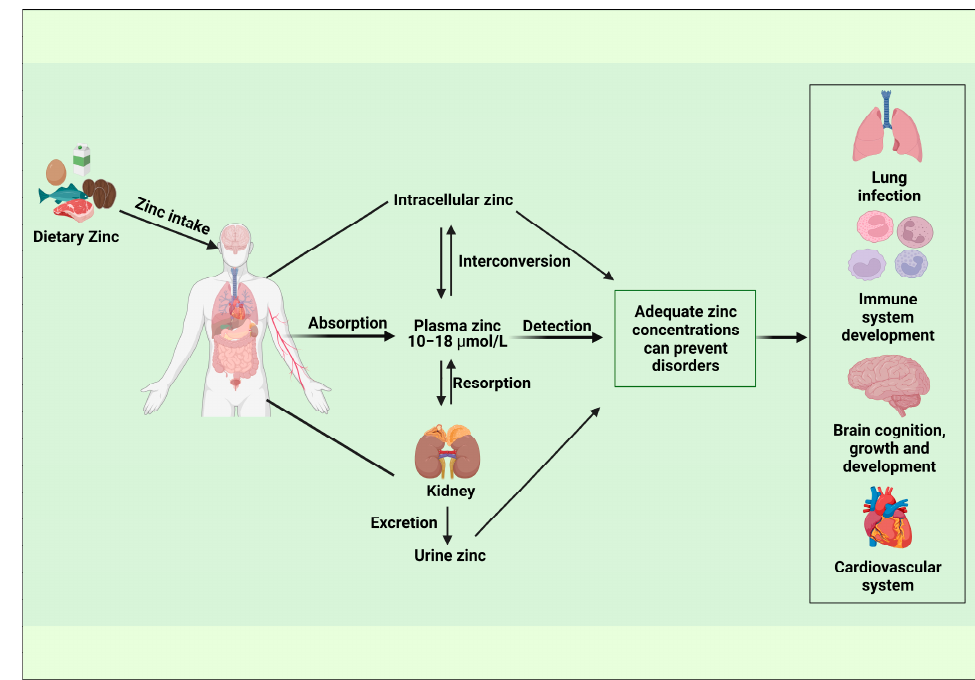
Figure 4. Epidemiological application of biomarkers associated with zinc homeostasis. (Created with